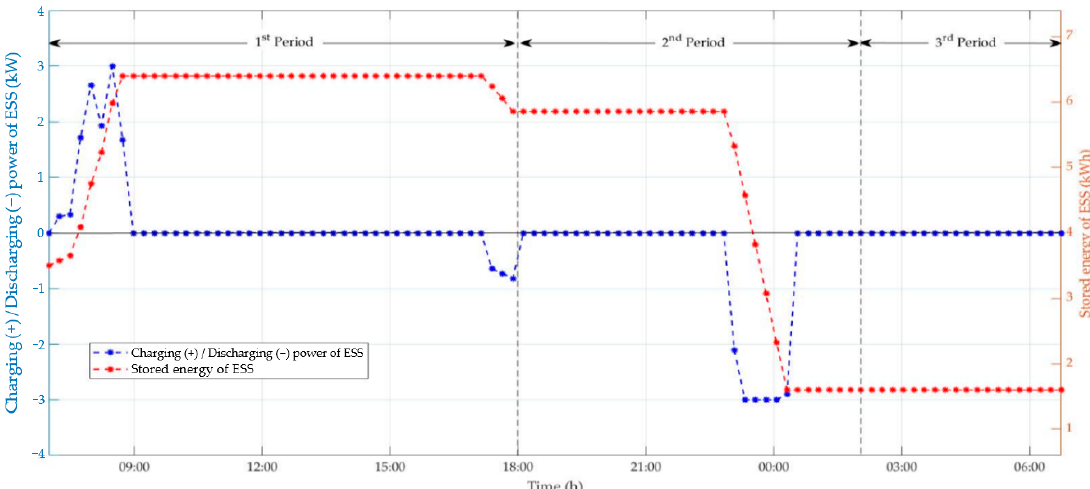
Figure 6. The charging (+)/discharging ( − ) power and stored energy of the PEV in each time slot.